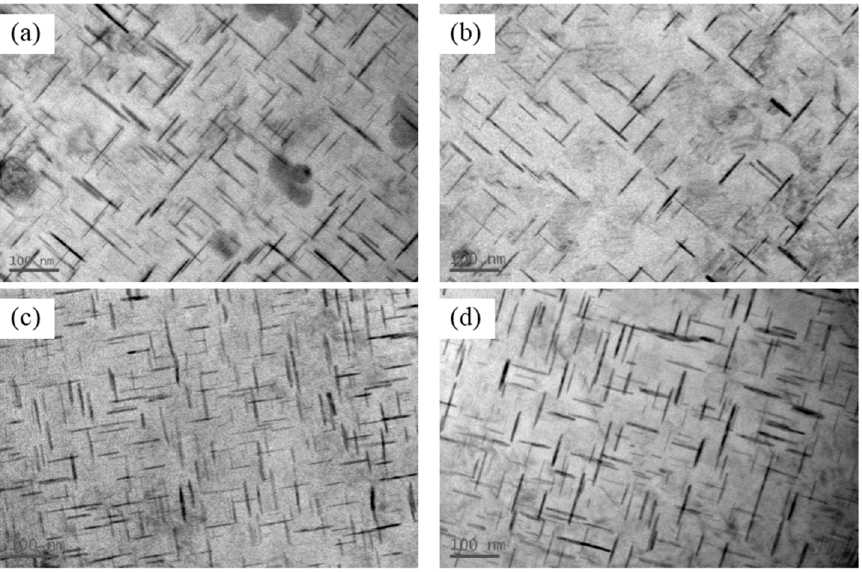
Figure 6. TEM images of 2219 aluminum alloy at 175 °C. ( a ) convention; ( b ) magnetic; ( c ) electric; ( d ) electromagnetic.